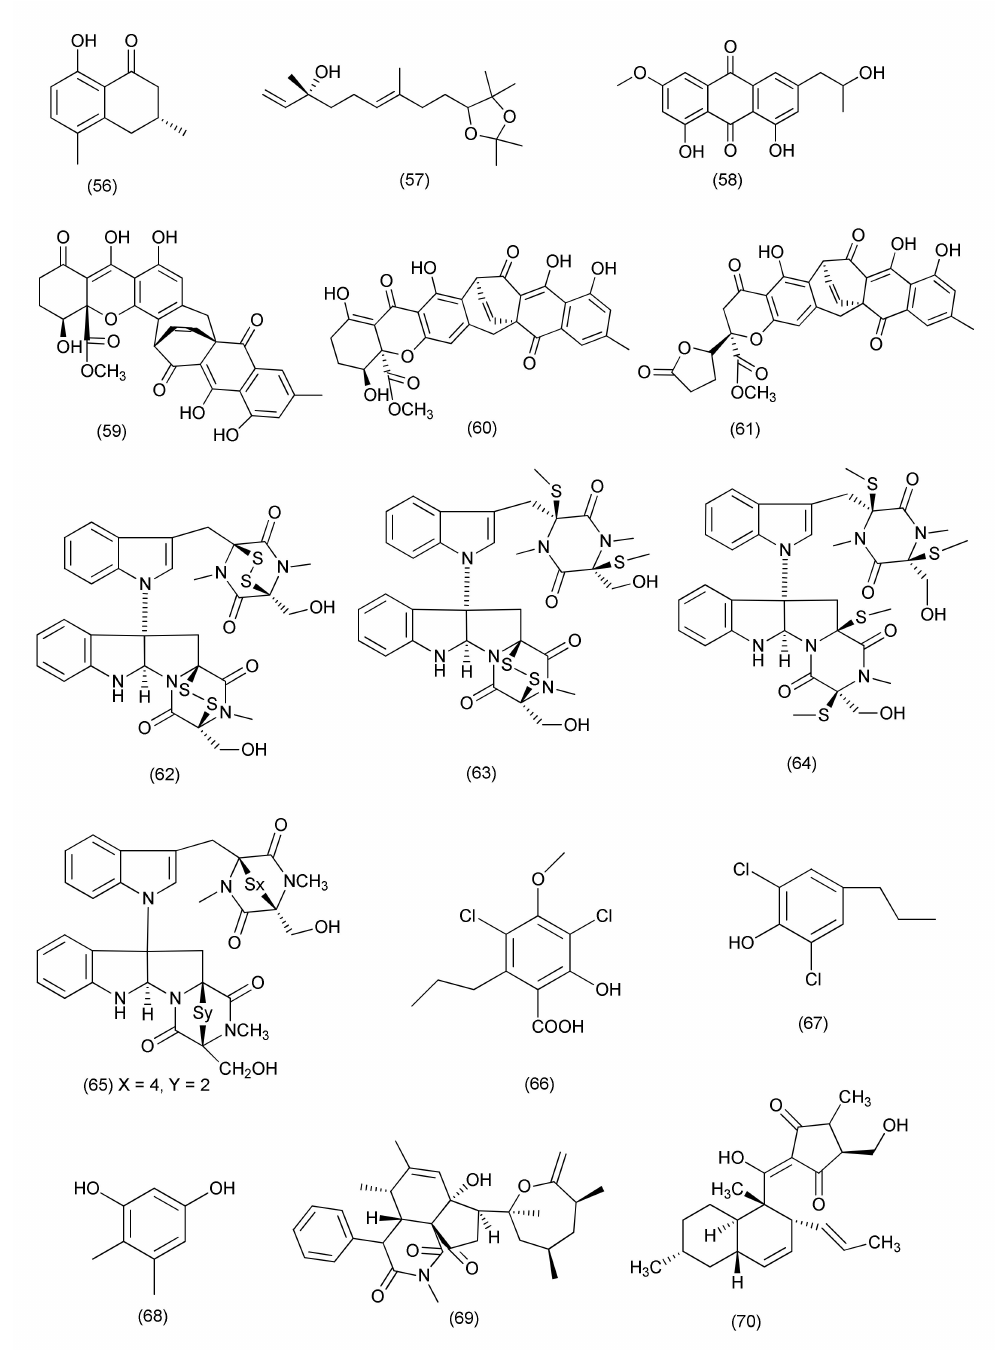
Figure 4. Structures of metabolites 56 – 70 isolated from